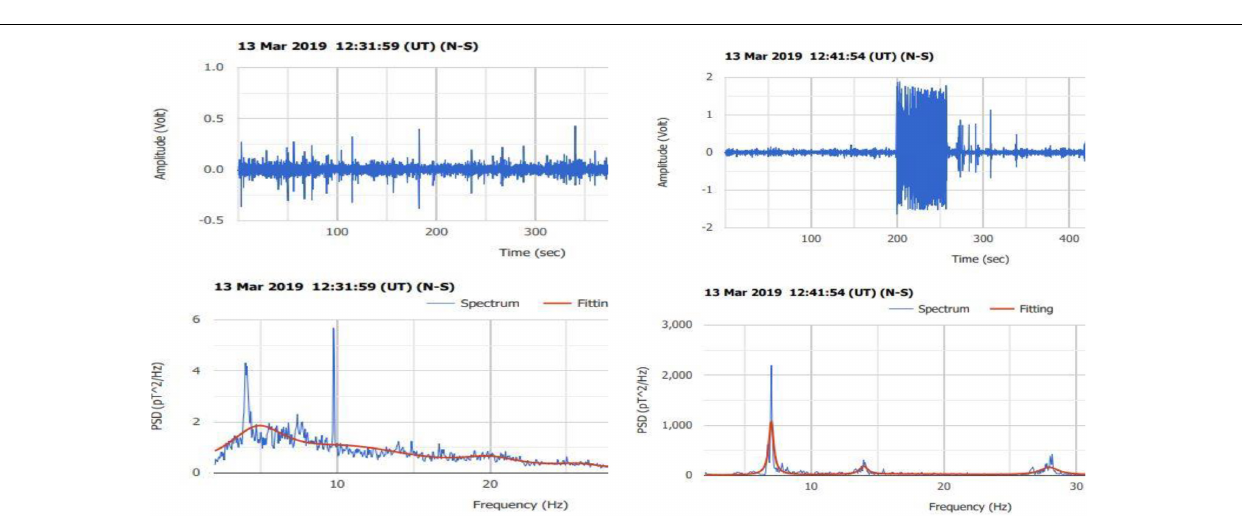
Frontiers in Earth Science |